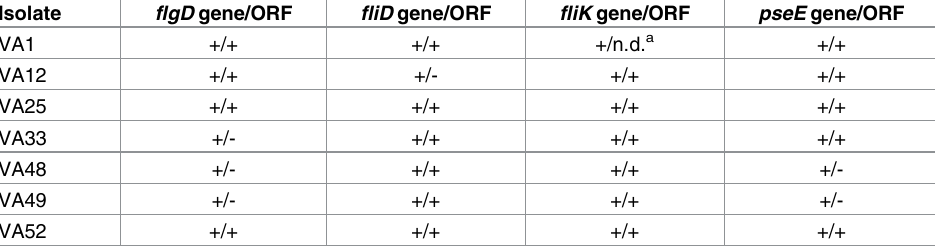
a Nucleotide sequence split over two contigs and an intact ORF could not be